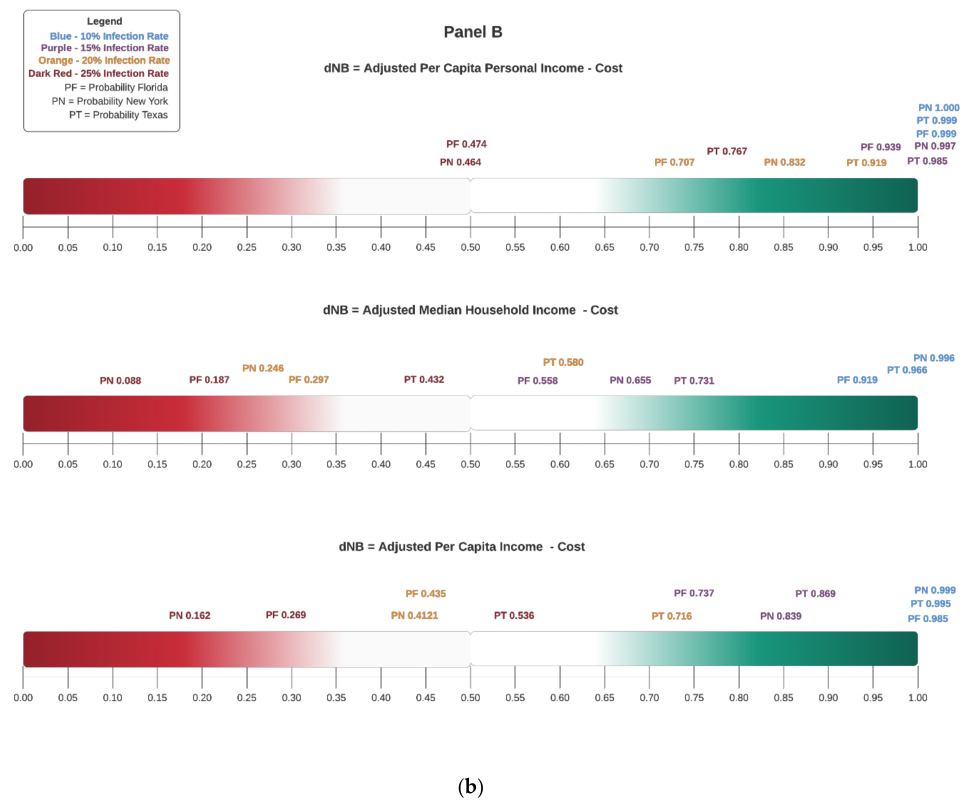
Figure 7. ( a ) Panel A— P ( ∆ NB > 0) with Unadjusted Income Values. ( b ) Panel B— P ( ∆ NB > 0) with Adjusted Income Values.